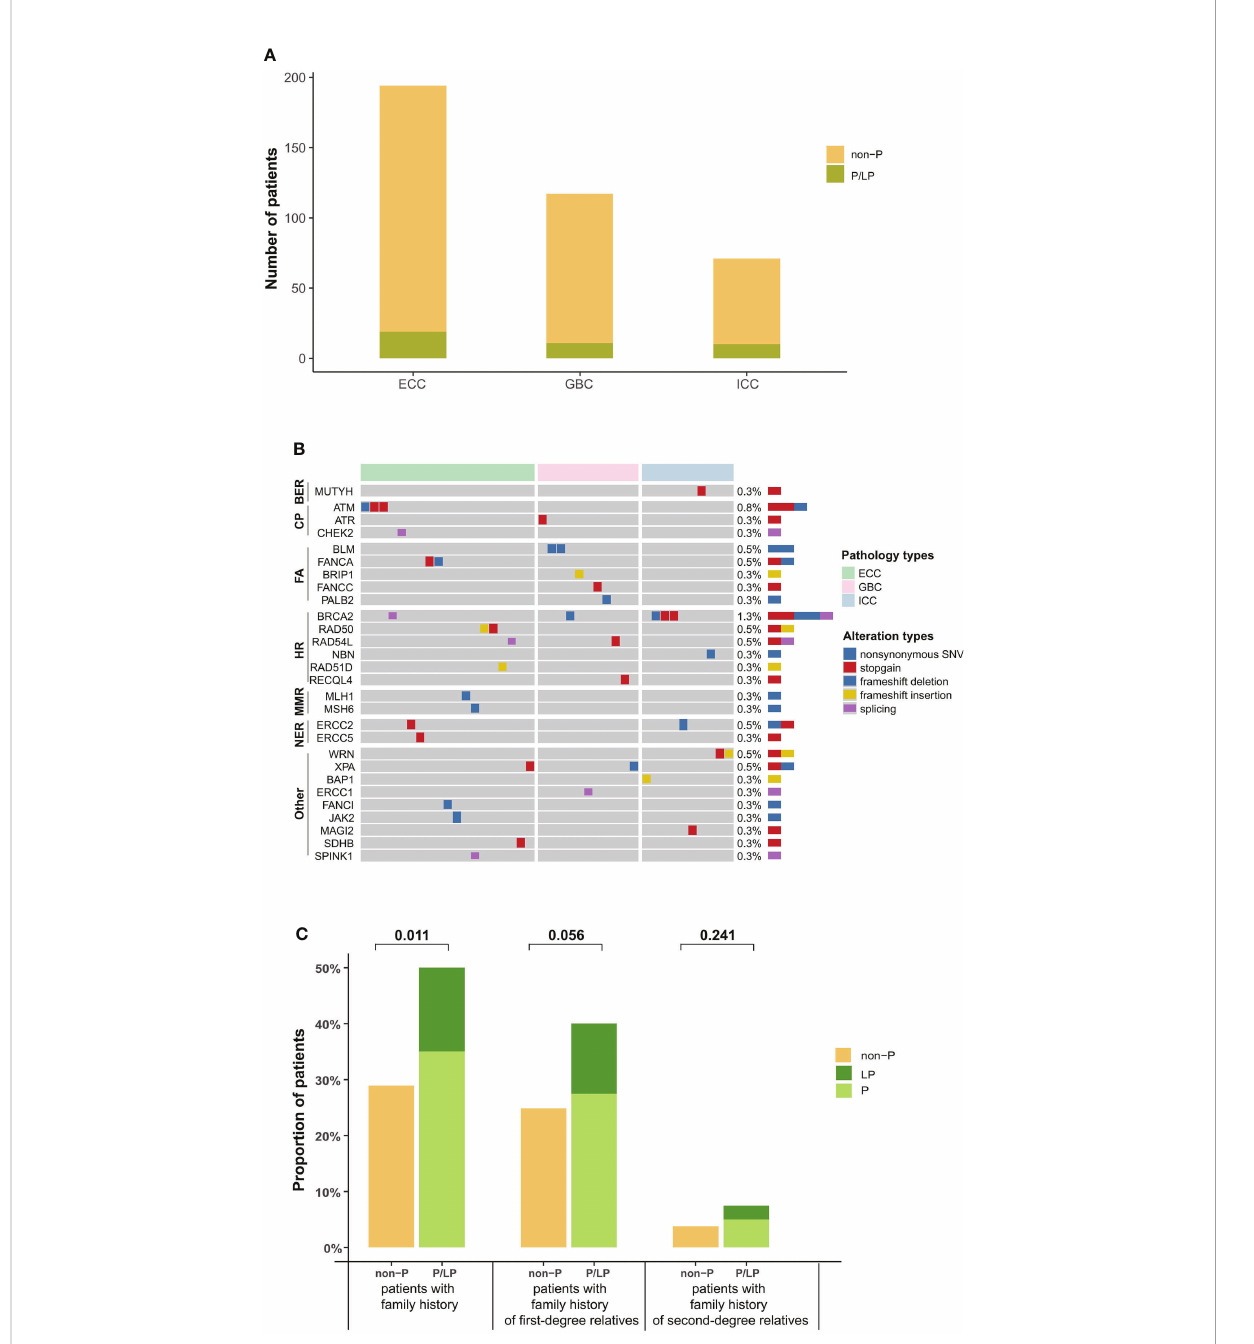
FIGURE 2 Distribution of P/LP germline alterations in 40 BTC patients. (A) Bar plots indicated the prevalence of P/LP germline alterations in each histological subtype (green). (B) P/LP germline altered genes and DDR pathways in 40 BTC patients are shown on the left, and the prevalence are shown on the right. (C) Family history of cancer in BTC patients with and without P/LP germline alteration. First-degree relatives include parents, children, brothers, and sisters, and other relatives are second-degree relatives. P/LP, pathogenic or likely pathogenic; BTC, biliary tract cancer; DDR, DNA damage